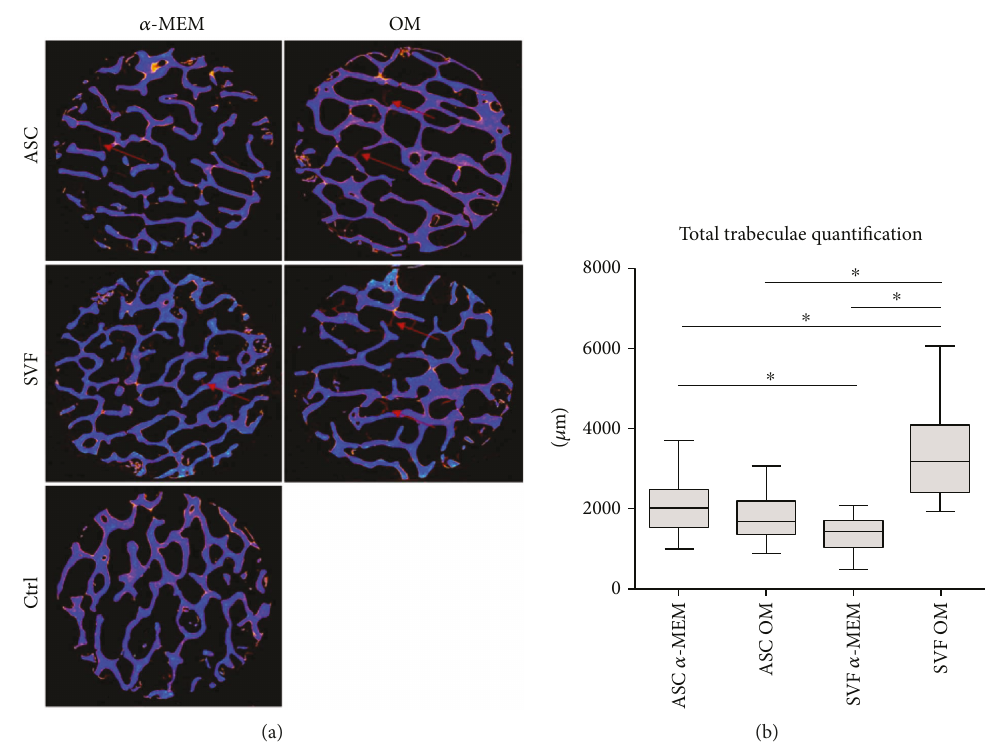
Figure 4: Analysis of new bone formation by micro-CT. (a) Representative images of X-ray tomography of SB with and without osteogenic medium (OM), after 60 days of culture with ASCs or SVF. The SB is shown in blue, whereas the newly formed mineralized tissue is in red (as indicated by the arrows). (b) Quanti fi cation of the newly formed mineralized tissue measured on SB cultured with ASCs or SVF, with or without OM. ∗ p < 0 05 .